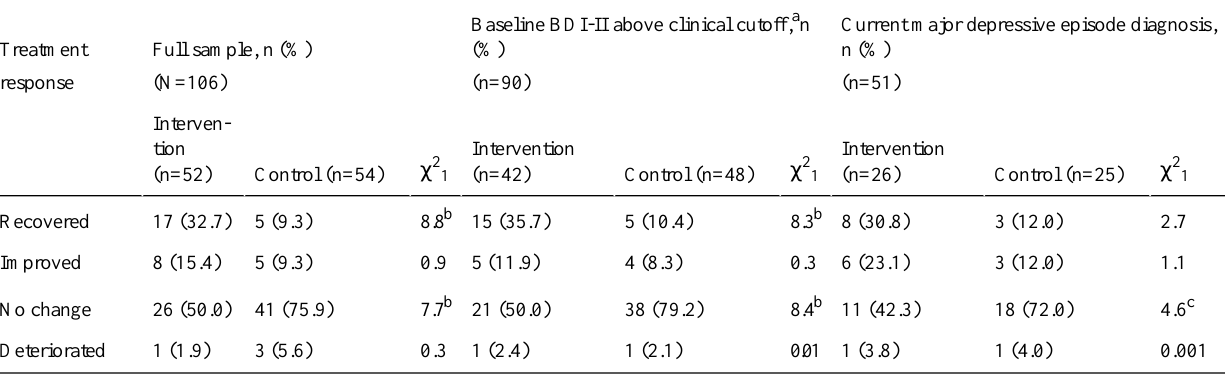
Table 3. Proportion of participants reaching the criteria for clinically significant improvement on the Beck Depression Inventory-II (BDI-II) at 7 weeks of treatment and results of chi-square tests ( χ 2